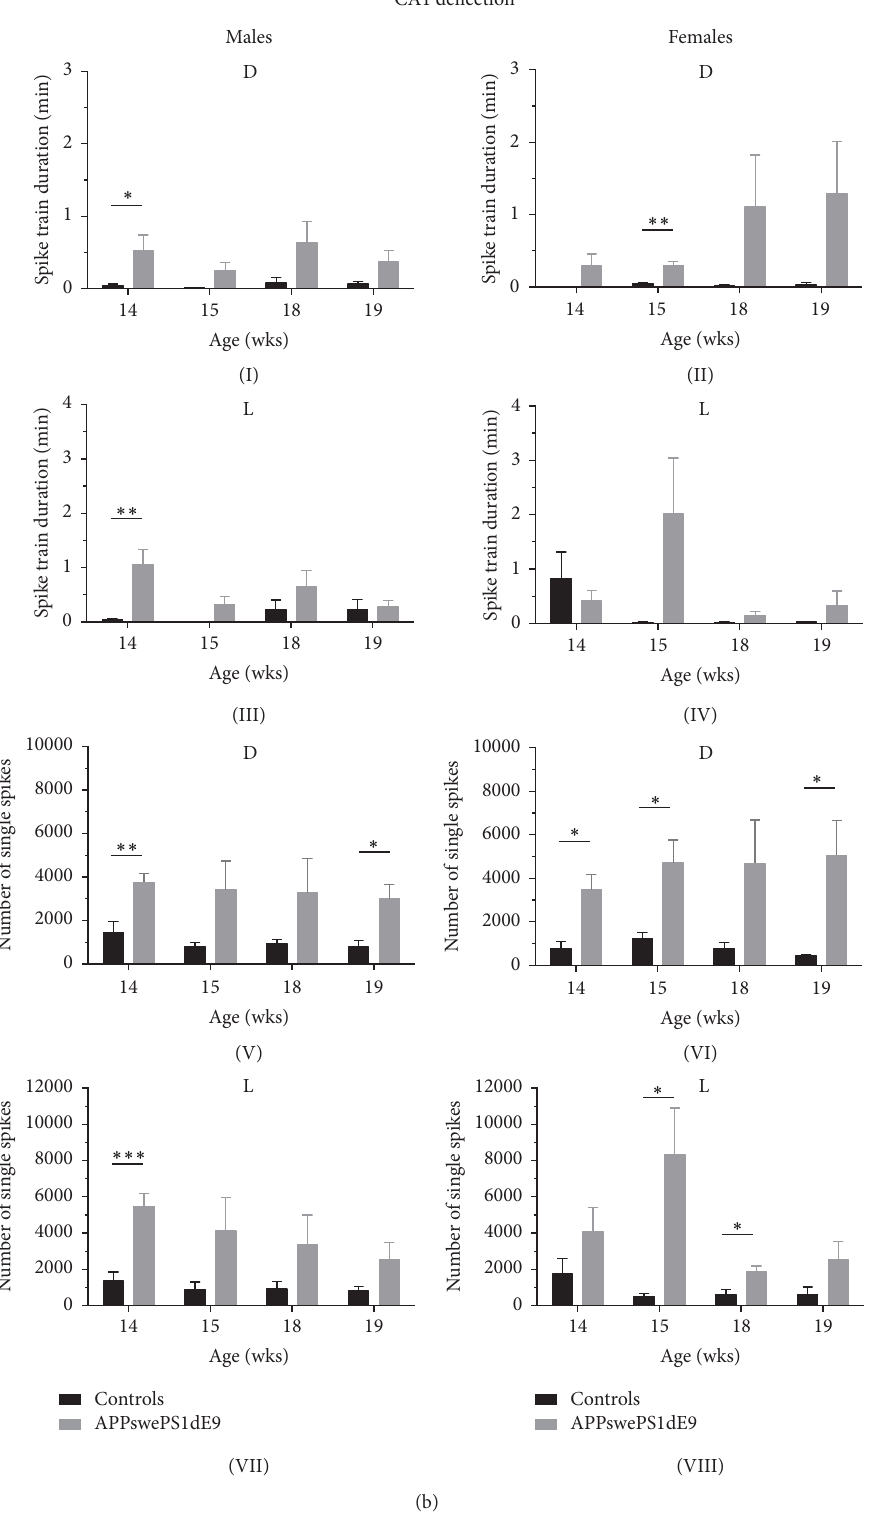
Figure3:ElectroencephalographicseizureanalysisincontrolsandAPPswePS1dE9.BothM1(a)andCA1(b)48 hrslong-termEEGrecordings were analyzed for electroencephalographic seizures using an automated seizure detection tool. Seizure parameters included the total spike train duration and the total number of spikes and were averaged for a single dark (D) or light (L) cycle for the various ages (14, 15, 18, and 19wks). ∗ 𝑝 < 0.05 ; ∗∗ 𝑝 < 0.01 ; ∗∗∗ 𝑝 < 0.001 , level of